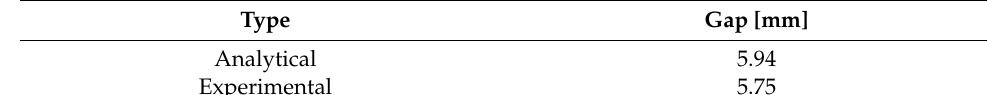
Table 2. Gaps between the surface electromagnet and edge of the flexible steel plate.